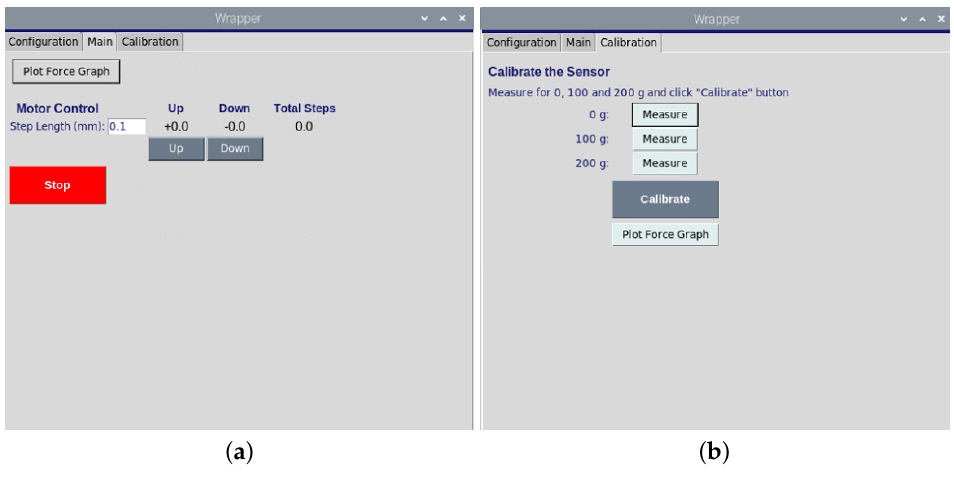
Figure 3. ( a ). The graphical user interface of motor movement opposite or toward the samples. ( b ). The graphical user for the calibration of load